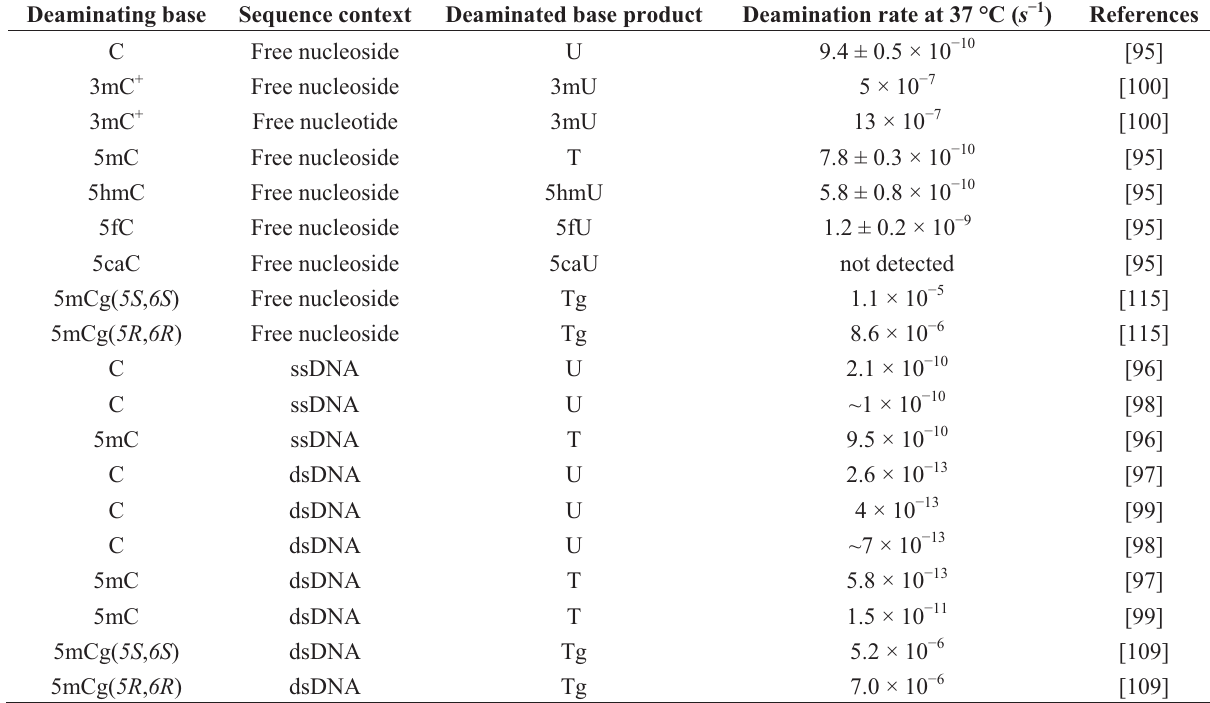
Table 2. Rates of spontaneous deamination for cytosines.